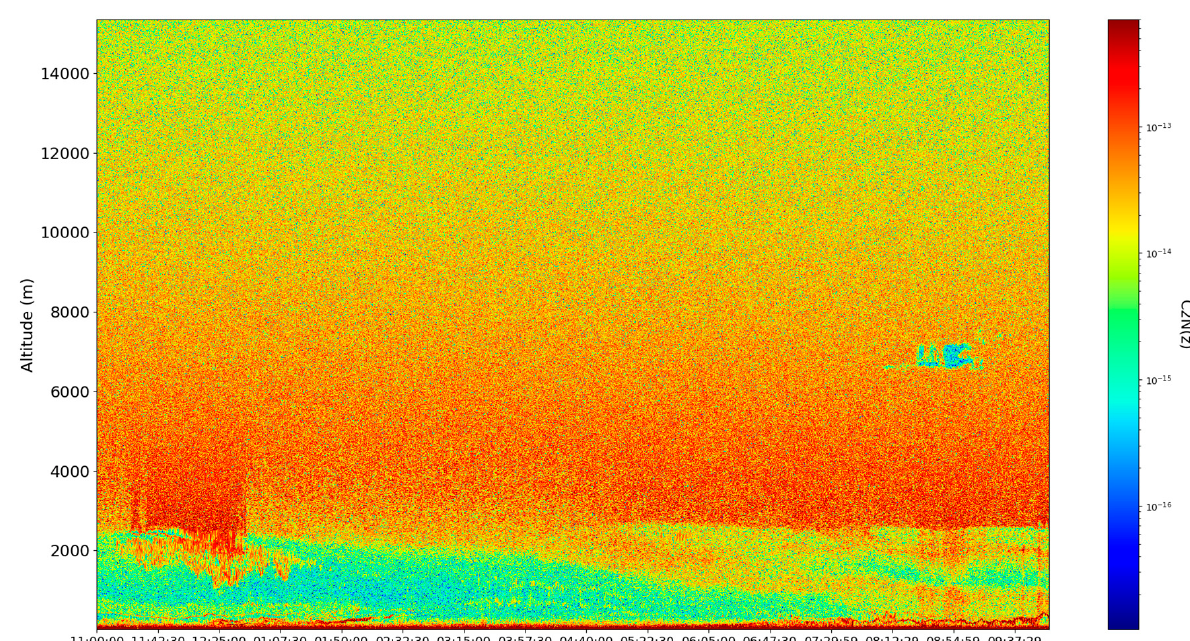
Figure 18. Zoomed-in (region of interest) C (cid:2898)(cid:2870) time series, λ = 1064 nm , Gala ț i, Romania, 23 Decem- ber 2021.